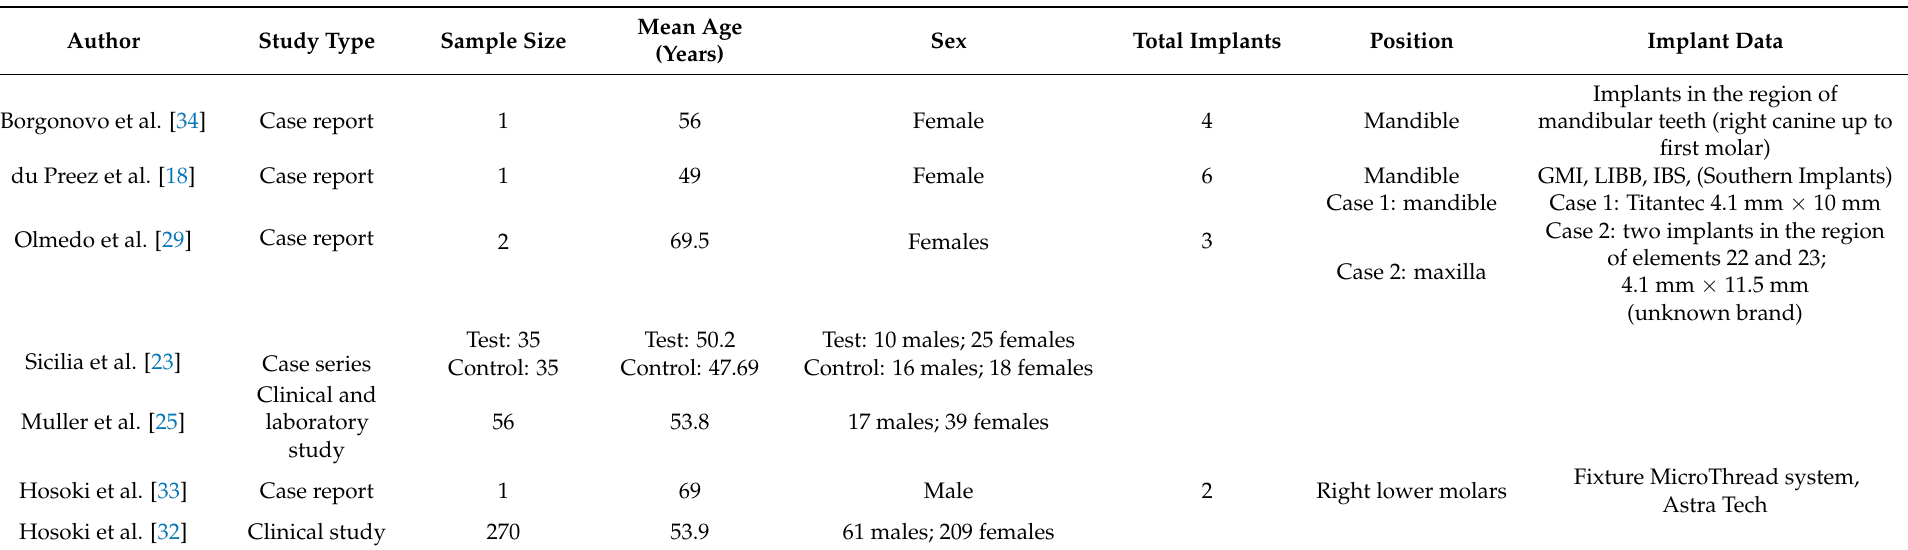
Table 1. Characteristics of the included studies and demographic data.